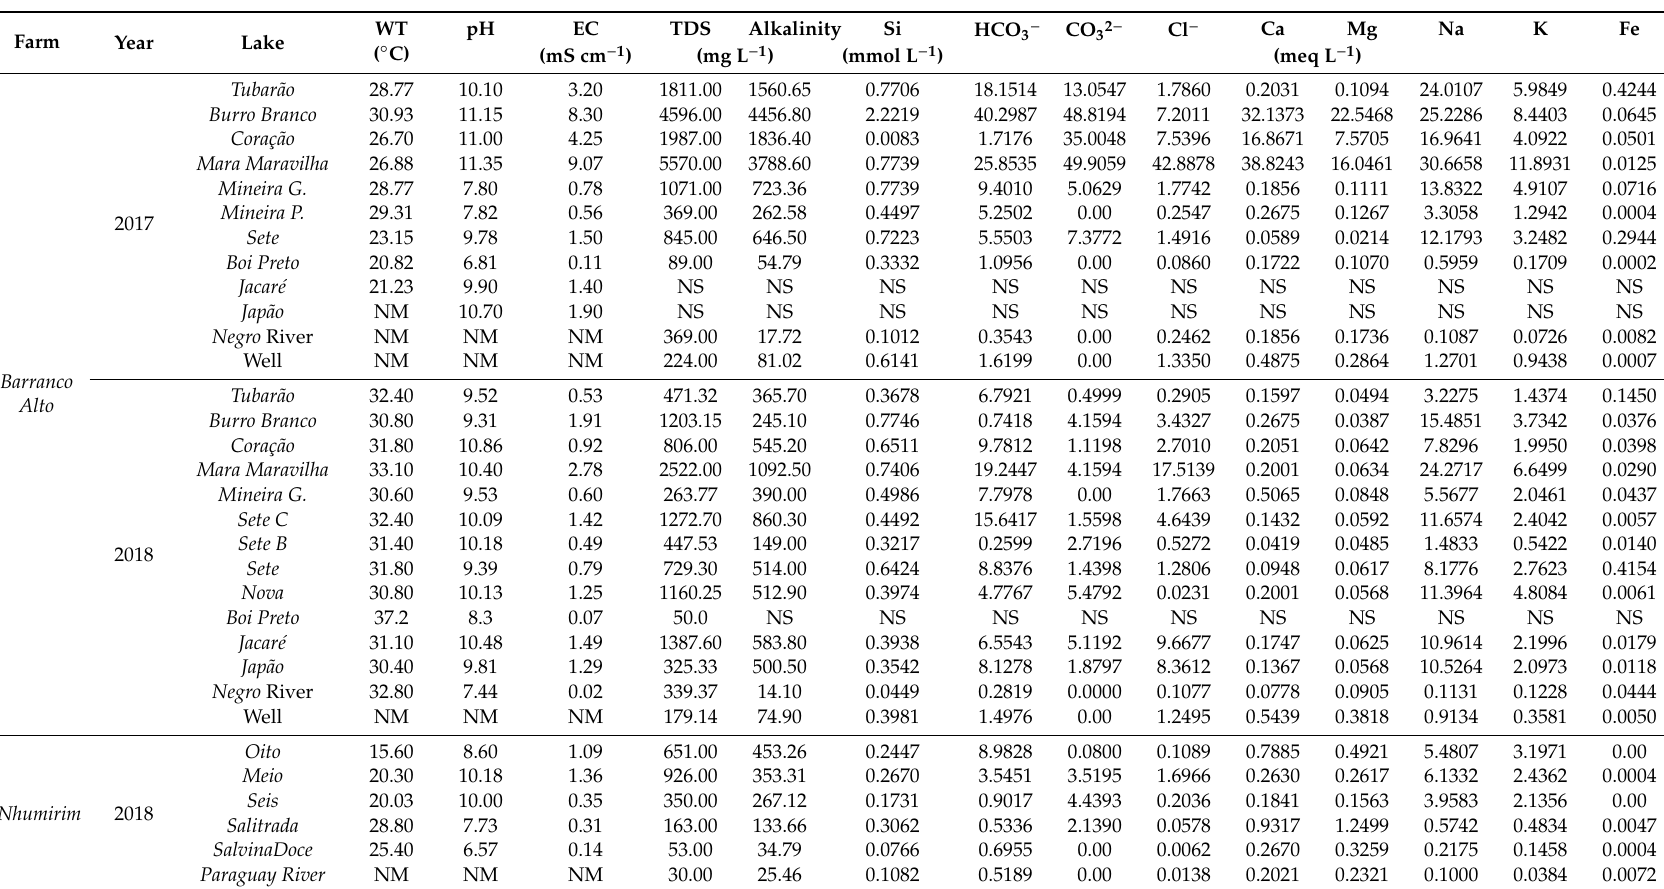
Table 3. Elements concentration in the water lakes of Barranco Alto farm (2017 and 2018) and Nhumirim farm (2018). WT—water temperature, EC—electric conductivity, TDS—total dissolved solids, NM—not measured, NS—not